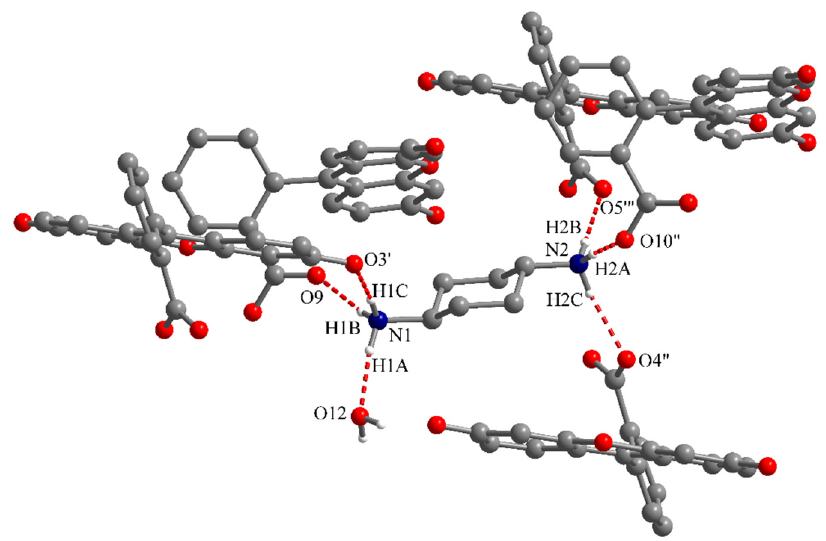
Figure 16. Detail of the hydrogen interactions established by H 2 diach 2+ dications in crystal 9 (part of the hydrogen atoms was omitted for clarity). Symmetry codes: ’ = − x, 1 − y, − z; “ = 1+x, y, z; ’” = 1 − x, 1 − y, 1 − z.